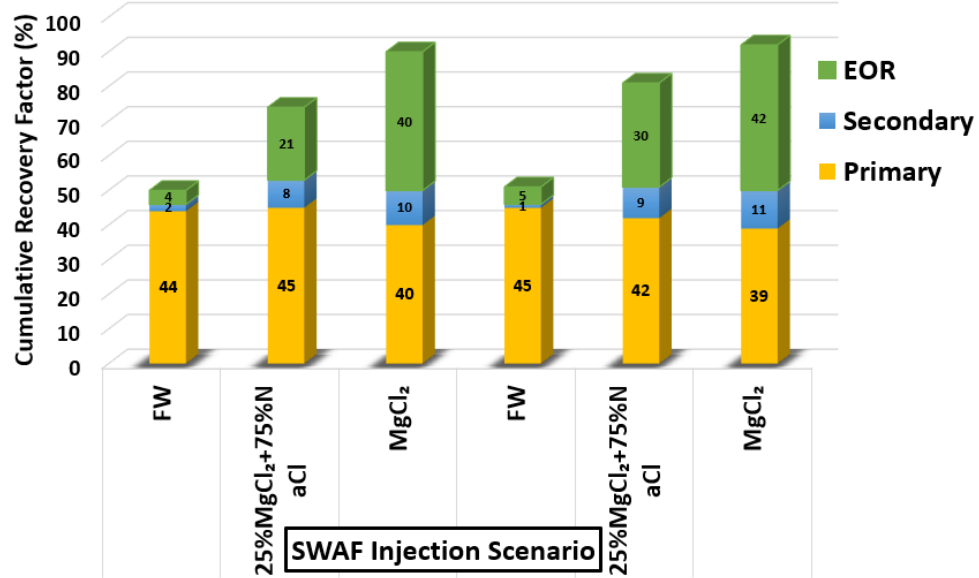
Figure 34. Smart water-assisted foam (SWAF) injection scenarios; the effect of crude oil type (Type A and Type B) with different smart water (SW) solutions (i.e., 3500 ppm) and at surfactant concentration of 1000 (ppm). For the best-case scenario (i.e., MgCl 2 ), the method works as an improved/enhanced (IOR/EOR) recovery method for the ionically modified brine, which goes up to 39% RF for the primary stage (i.e., formation water), 11% RF (i.e., 50% cumulative OIIC) for the secondary stage (i.e., smart water injection), and 92% cumulative OIIC for the tertiary stage (SAG injection i.e., SAS, gas, SAS, and gas).